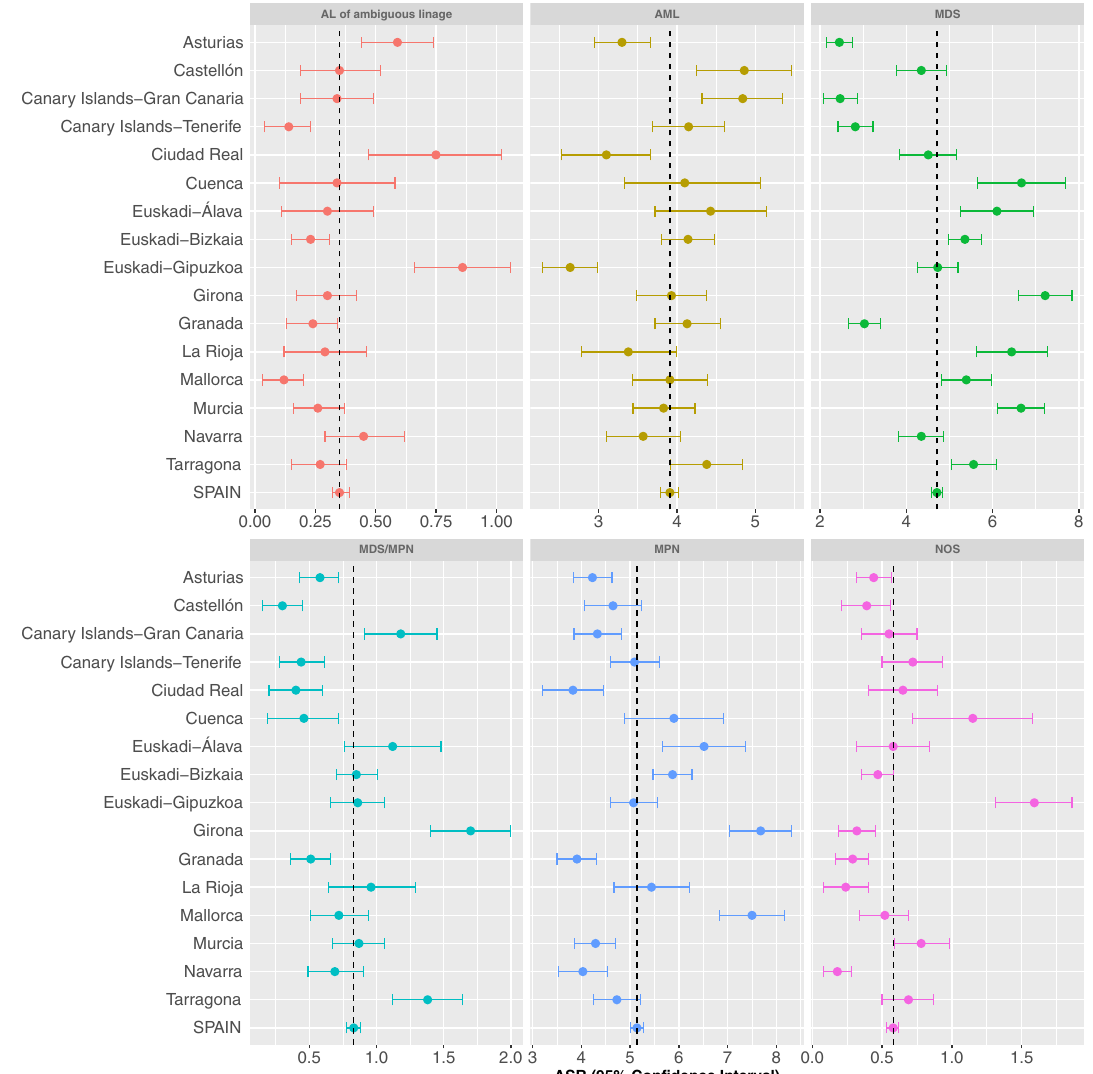
Figure 2. Age-standardized incidence rates (ASR E ) of myeloid neoplasms diagnosed in Spain during 2002– 2013 by region. AML acute myeloid leukemia, AL acute leukemia of ambiguous lineage, MDS myelodysplastic syndromes, MPN myeloproliferative neoplasms, NOS not-otherwise specified. Rates are expressed per 100,000